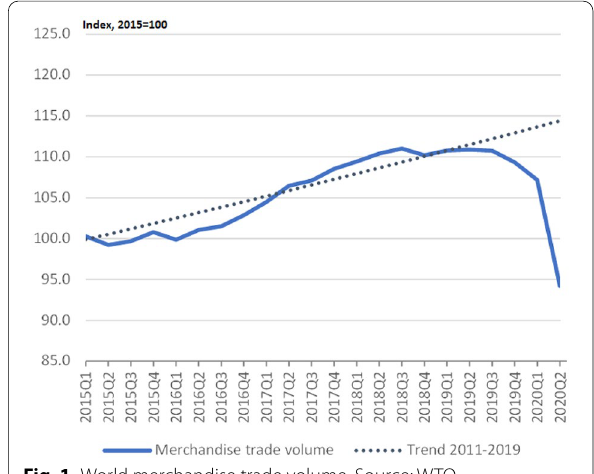
Fig. 1 World merchandise trade volume. Source: